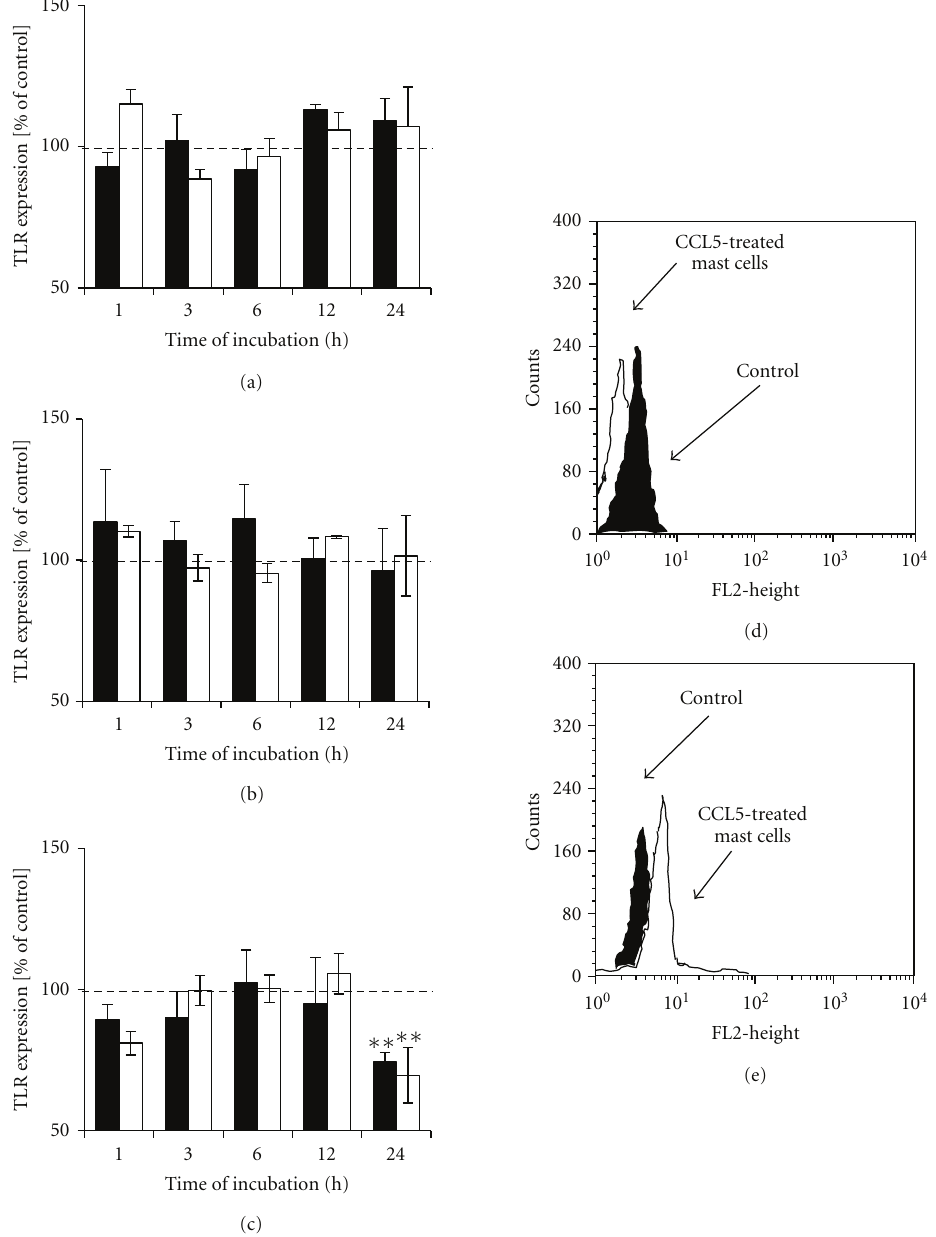
Figure 4: The e ff ect of (a) TNF, (b) IL-6, and (c) CCL5 on TLR2 expression on rat mast cells. Mast cells were incubated with cytokines or cDMEM (control TLR2 expression on unstimulated cells referred to as 100%) for 1,3, 6,12, or 24 hours. Cytokine concentrations − 1pg/mL (dark bars) and 10 2 pg/mL (bright bars). Results are presented as a percentage of control TLR2 expression. Each point represents the mean ± SEM of 6 independent experiments. ∗∗ P < . 01. (d) Representative flow cytometry histogram showing TLR2 expression on rat mast cells treated with 1pg/mL CCL5 for 24h. (e) Representative flow cytometry histogram showing TLR2 expression on rat mast cells treated with 10 2 pg/mL CCL5 for 24h. Filled histograms: untreated mast cells (control) and open histograms: CCL5-treated mast cells.